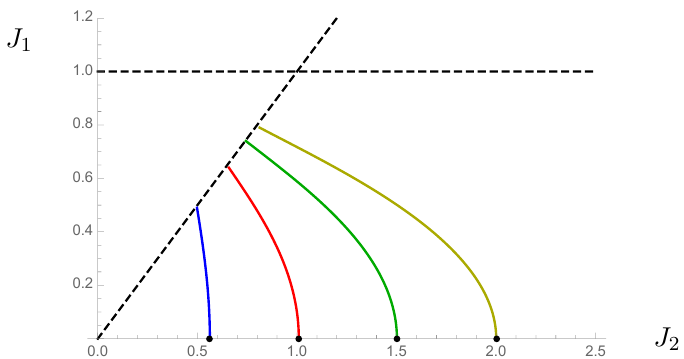
Figure 3 . Phase diagram for d = 1. The curves correspond to z = 1 (blue), z = 2 (red), z = 3 (green) and z = 4 (yellow). To the left of each curve the shortest geodesic is connected, whereas to the right the shortest geodesic is disconnected. The dashed lines mark the boundaries of the physical region J 1 < 1 and J 2 > J 1 . The black dots are extracted directly at J 1 =